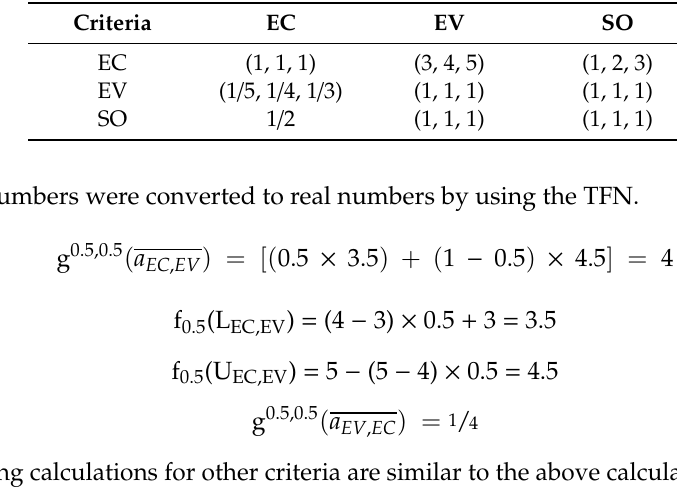
Table 4. Fuzzy comparison matrices for GOAL.